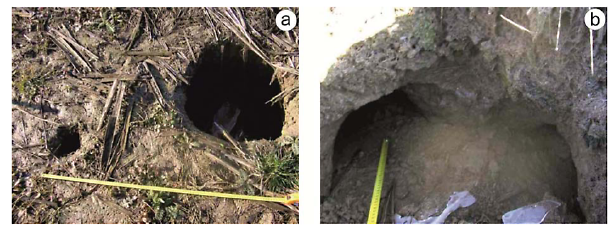
Fig. 8. (a) Vertical conduit (left) and sinkhole-like feature (right); (b) sub-horizontal tunnels departing from the bottom of the